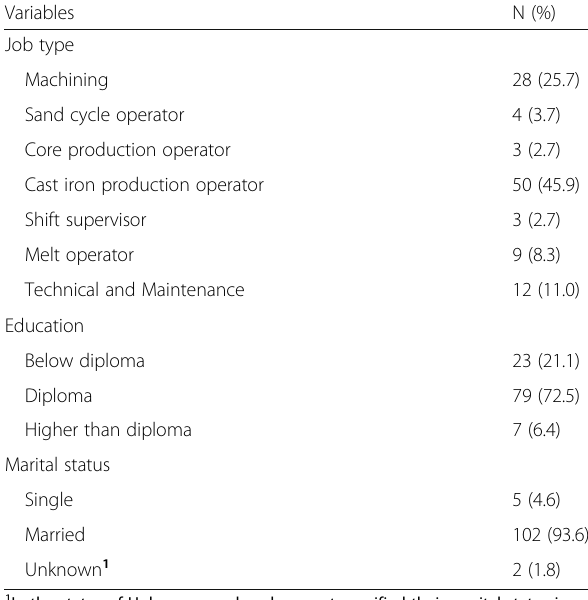
Table 2 Distribution of categorical demographic variables of foundry workers ( N = 109) in Tehran, Iran, 2016 Variables